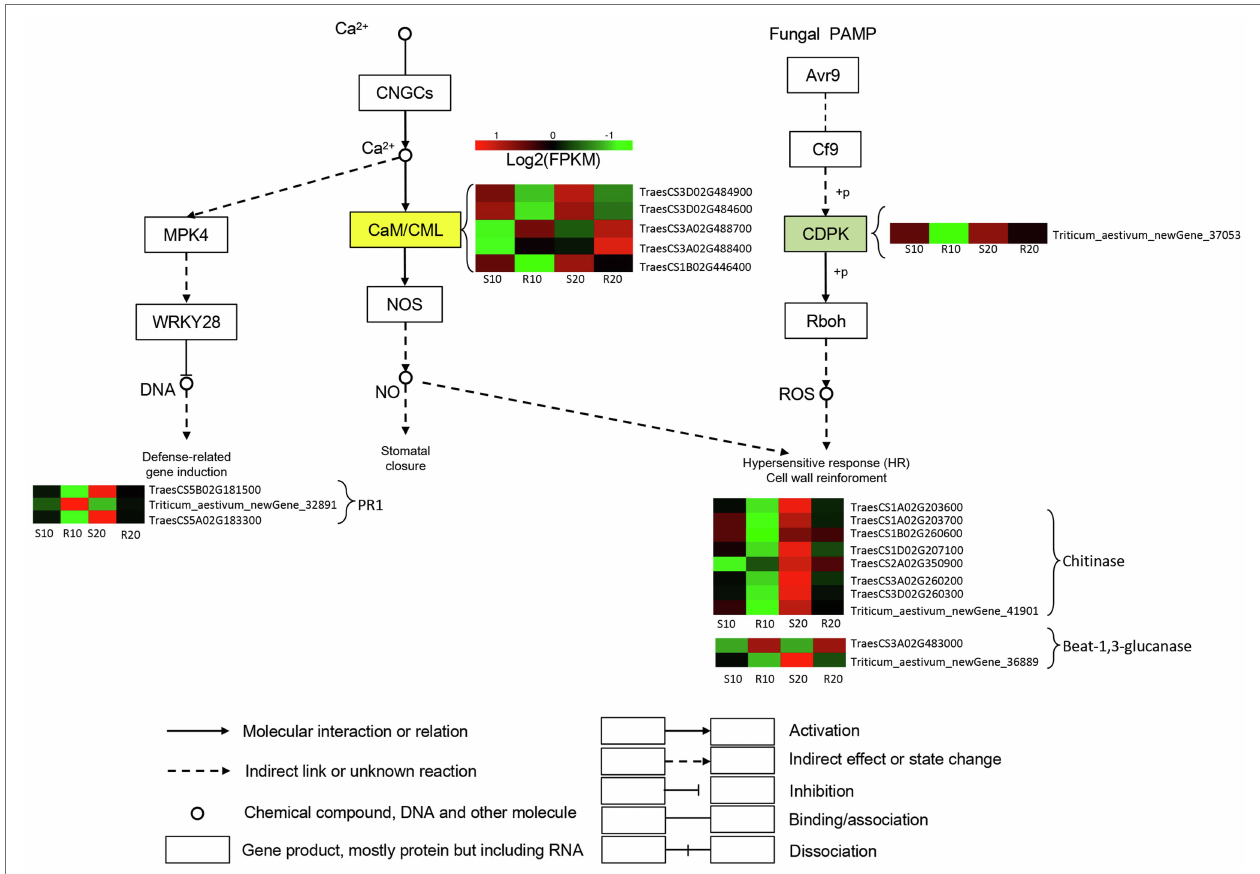
FIGURE 6 | DEGs related to triticale– Pst interaction pathway. Expression values are presented as log 2 FPKM values (red for upregulated and green for downregulated), and the vertical columns, from left to right, represent S10, R10, S20, and R20. The color of the background indicates the pattern of gene expression: red for upregulation, green for downregulation, and yellow for both upregulation and